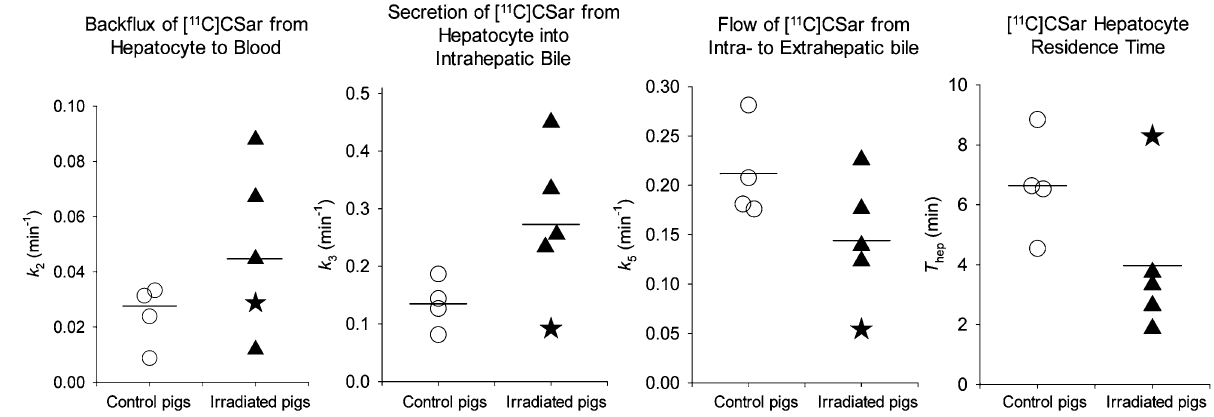
Figure 1. Individual rate constants for the hepatobiliary transport of [ 11 C]CSar estimated from PET in control and irradiated pigs. Control pigs are shown as white circles, irradiated pigs as black triangles (pig with inflammatory cholestasis indicated as a star; Pig R4). Horizontal bars represent group means.